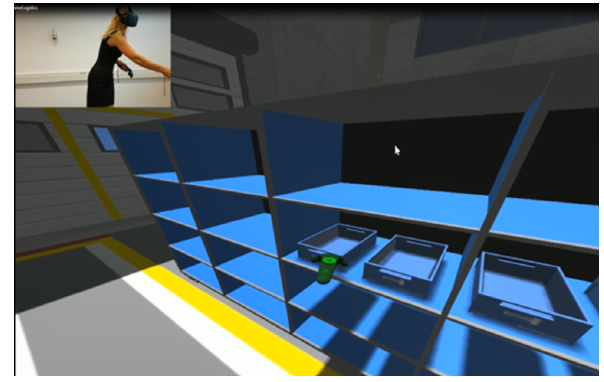
Figure 2: Example of virtual reality application within storage logis- tics of small